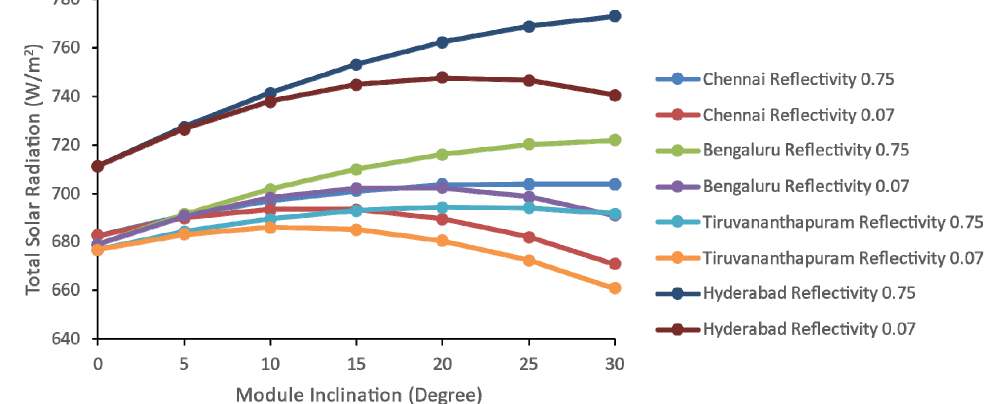
Figure 3. Total solar radiation variation with module inclination for Chennai, Bengaluru, Thiruvananthapuram, and